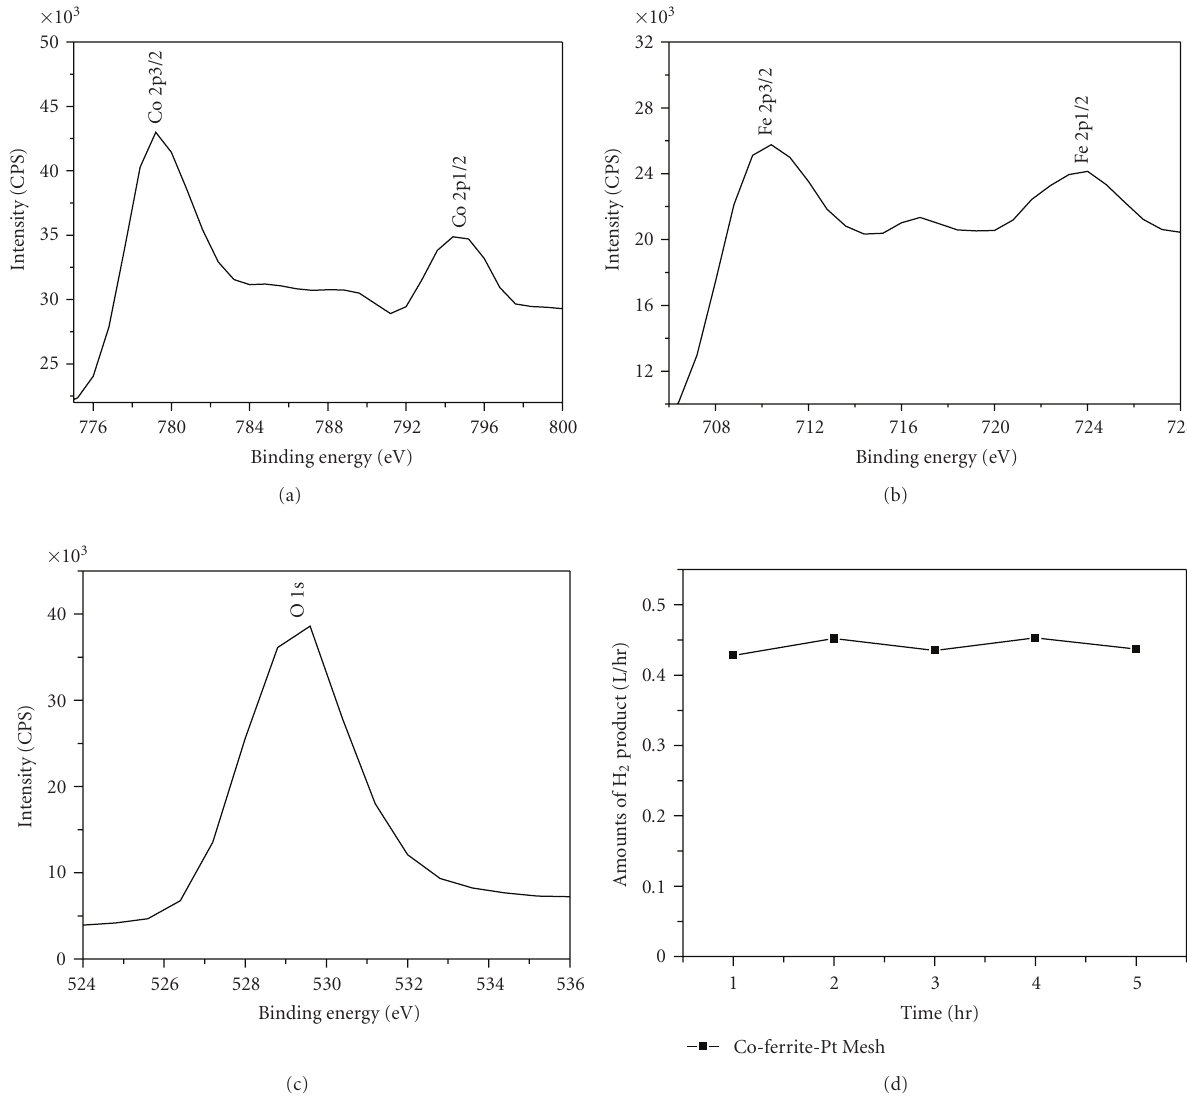
Figure 3: The XPS spectra of (a) Co 2p, (b) Fe 2p, (c) O 1s core levels, and (d) quantitative measurement of hydrogen production rate using cobaltite